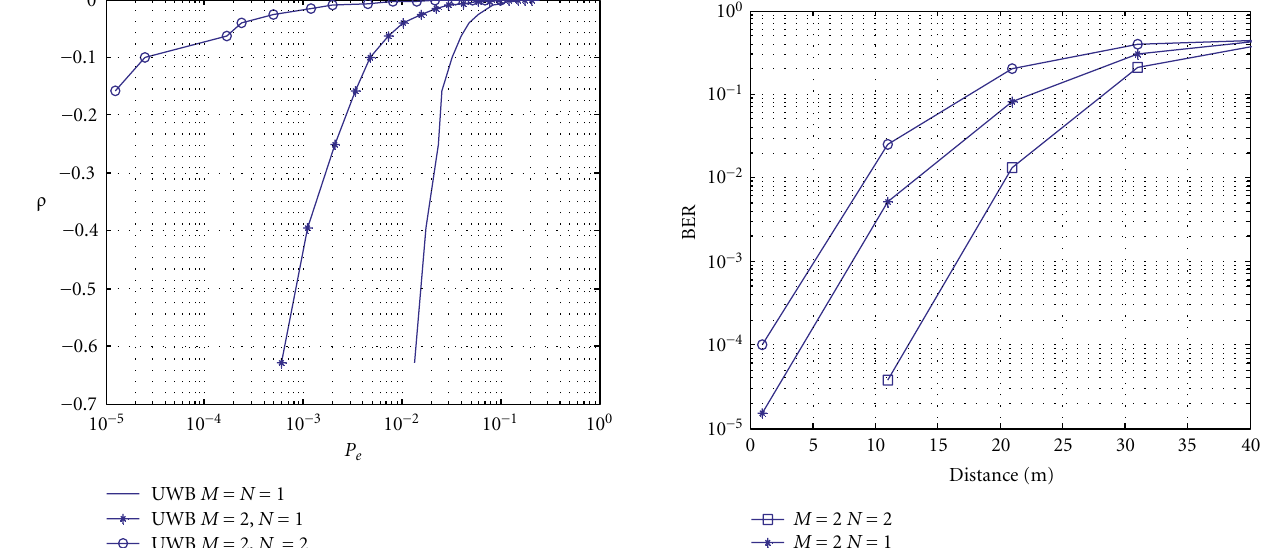
Figure 2: Tradeo ff between LPD and anti-jamming.